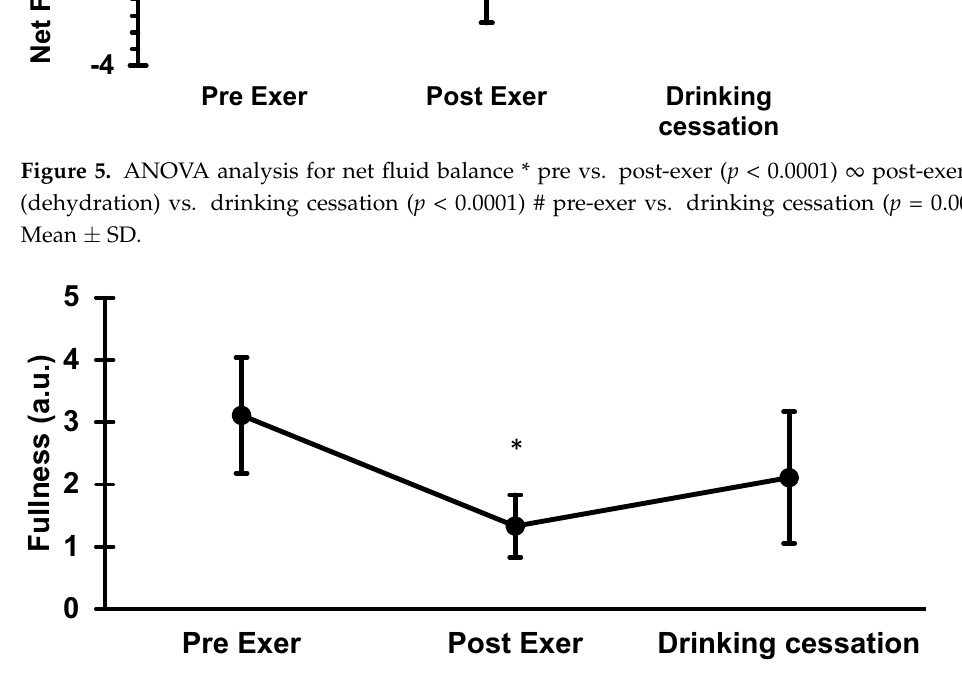
Figure 6. ANOVA analysis for fullness. Pre-exer and drinking cessation point ( p = 0.055), pre-exer vs. post-exer (dehydration) ( p = 0.0012), post-exer (dehydration) vs. drinking cessation ( p = 0.251). * p > 0.05